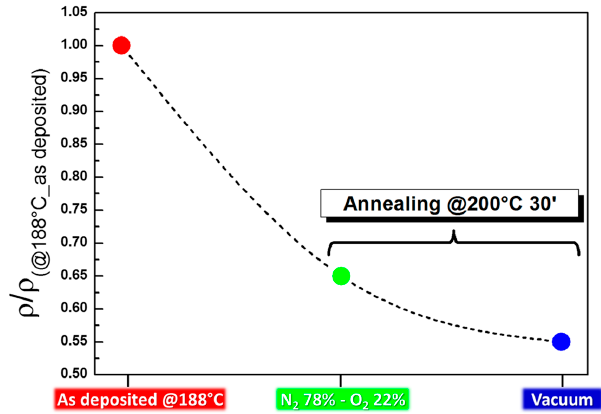
Figure 8. The effect of adding ex situ heating on the layer resistivity. Note that the presence of oxygen species in the annealing ambient does not negatively affect the layer conductivity.